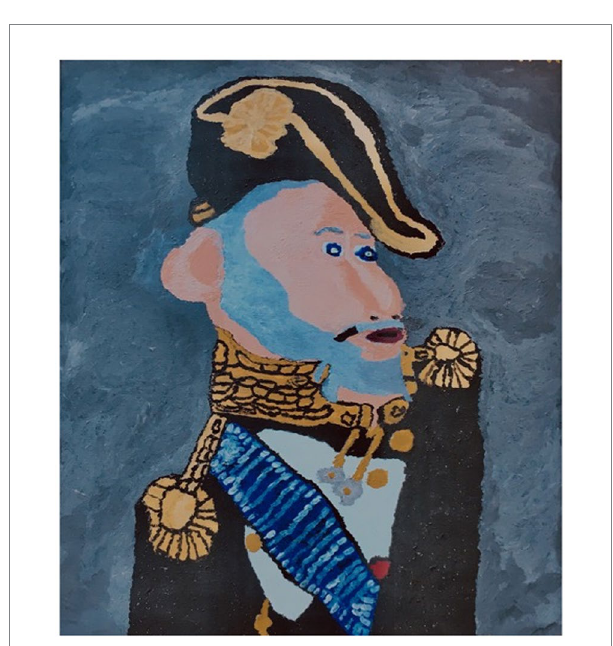
FIGURE 3 This artwork was painted by our patient in 2022, a painting inspired by an original portrait of former Swedish king Oscar II. This painting is an example of her practically applied